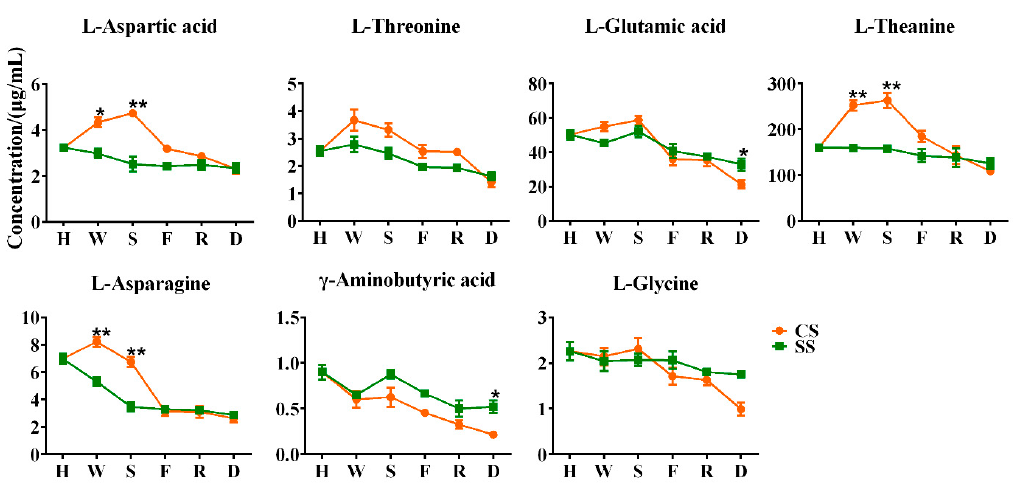
Figure 6. Dynamic changes of free amino acid content in steams. H stands for harvesting, W stands for withering, S stands for shaking, F stands for firing, R stands for rolling, and D stands for drying (CS, combined stem; SS, separated stem; **, p < 0.01; *, p < 0.05).